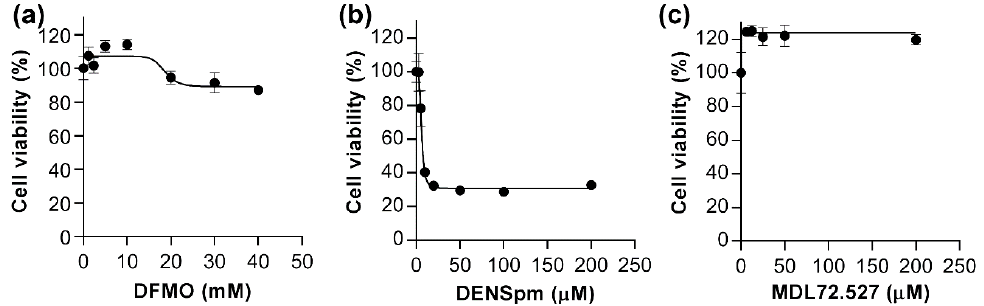
Figure 2. Toxicity of DFMO, DENSpm, and MDL72.527. Differentiated HepaRG cells were